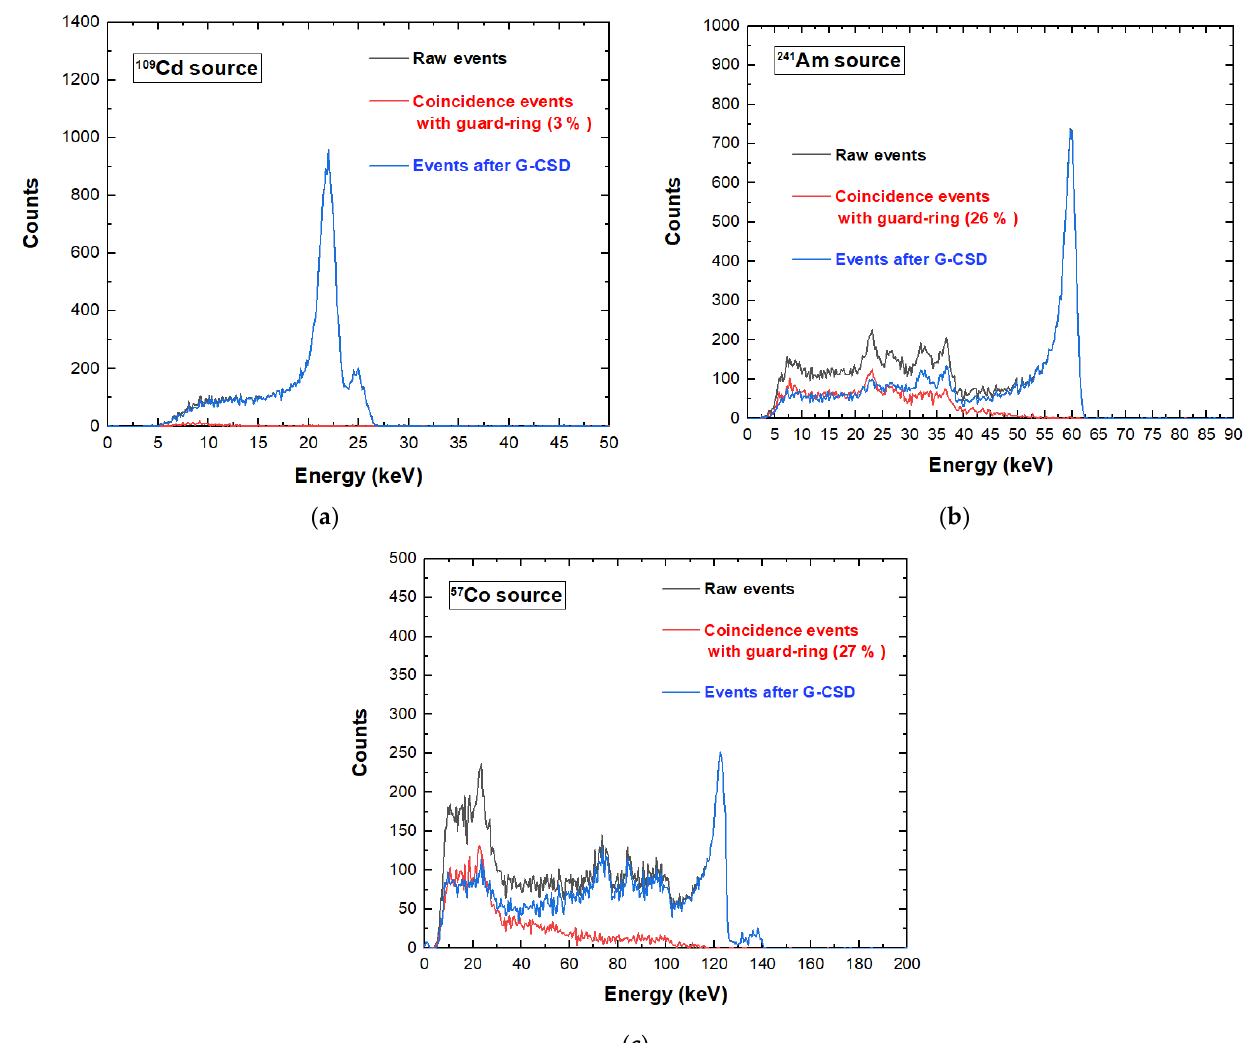
Figure 9. Charge sharing measurements of a tested pixel under ( a ) 109 Cd, ( b ) 241 Am and ( c ) 57 Co sources. The blue lines represent the uncollimated energy spectra after charge sharing discrimination with the internal-guard ring (G-CSD). The raw spectra (black line) of all events and the spectra of the coincidence events with the internal guard-ring (red line) are also shown.